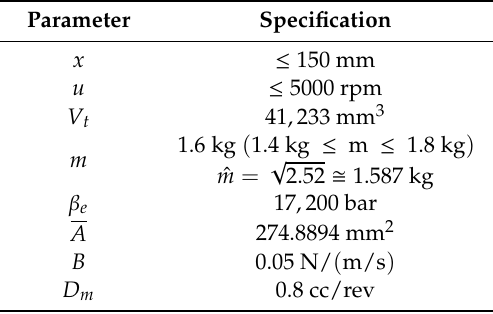
Table 2. Parameters for electro-hydraulic actuator (EHA) simulation.